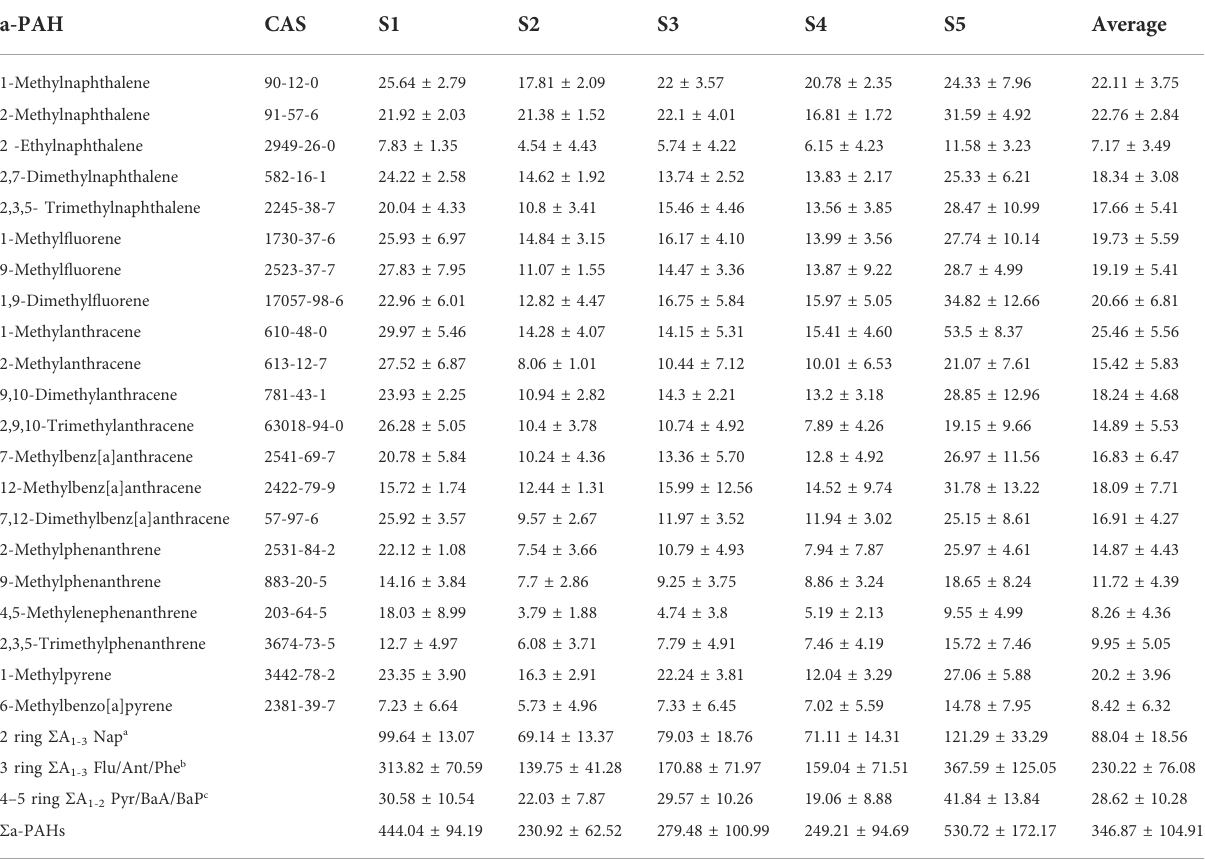
TABLE 3 Concentration of (cid:1) 21 a-PAHs in samples of soil (ng/g). a-PAH